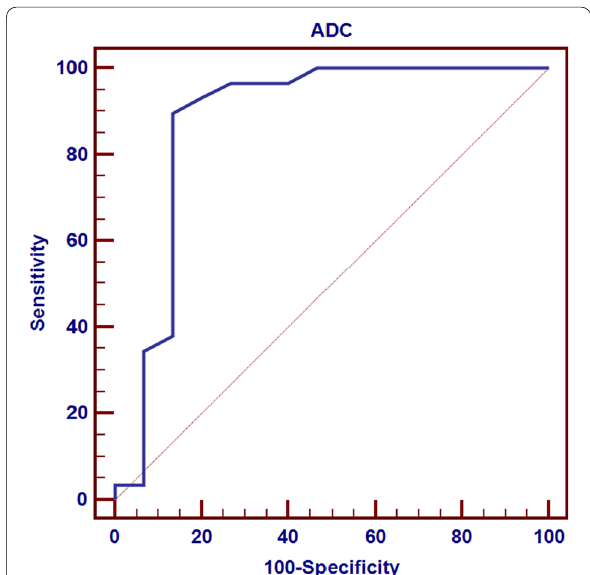
Fig. 2 Receiver operating characteristic curve (ROC) of ADC value of MRI as a predictor of pathological